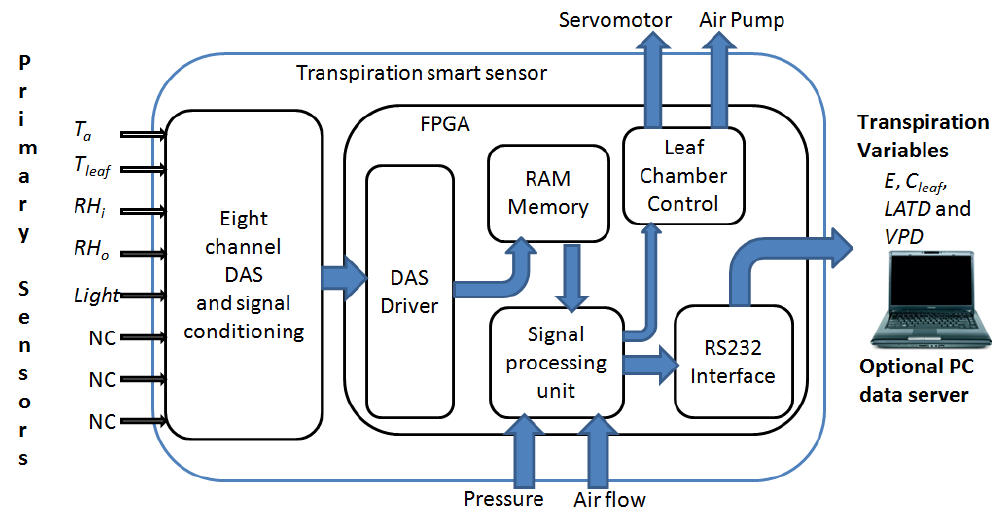
Figure 2 . Transpiration smart sensor